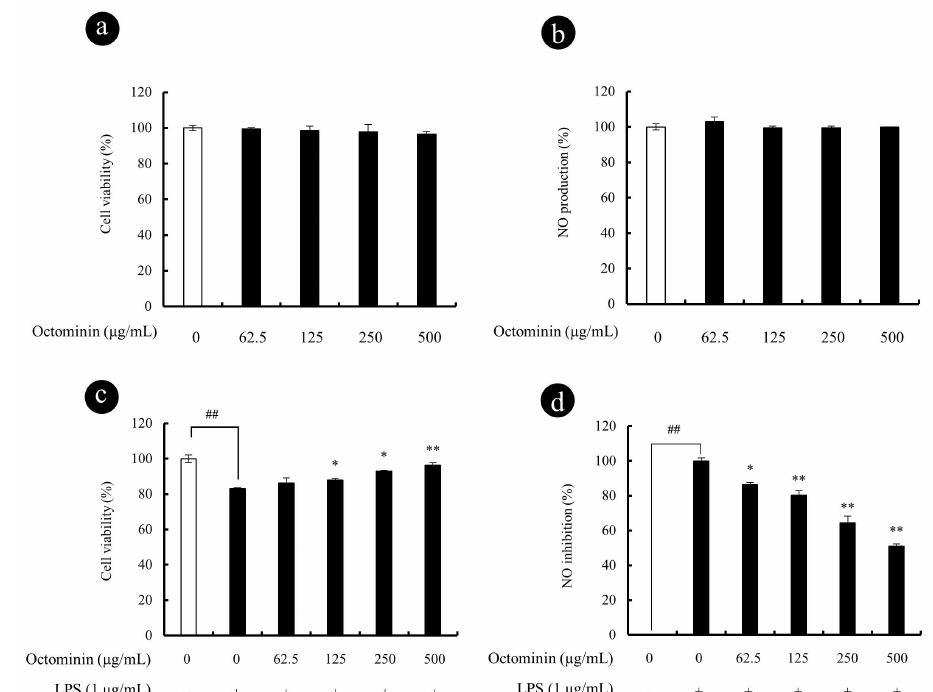
Figure 2. Cyto-protective and NO inhibitory e ff ect of Octominin in LPS-activated RAW 264.7 macrophages. Cytotoxicity ( a ) and NO production ( b ) of Octominin in RAW 264.7 macrophages; Cytoprotective ( c ) and NO inhibitory ( d ) e ff ect of Octominin in LPS-stimulated RAW 264.7 macrophages. Macrophages were seeded in 24-well plates and incubate for 24 h. Then, Octominin (62.5~500 µ g / mL) treated to each well and incubate for 1 h and exposed to LPS (1 µ g / mL). After 24 h, cells and culture supernatants were used to determine viability (MTT) and NO production, respectively. Experiments were triplicated to evaluate the data, and the mean value is expressed as ± SD. Statistical significance was determined versus vehicle-treated control group ( # < 0.05 and ## < 0.01) or LPS-treated group (* p < 0.05 and p ** <